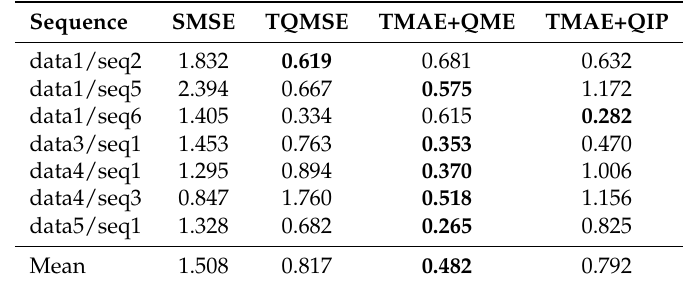
Table 4. Comparison of trajectory RMSE in meters for excerpts of the test sequences from